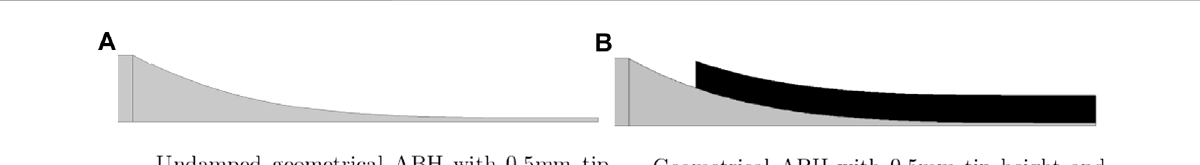
FIGURE 2 Diagrams showing the two ABH con fi gurations. (A) Geometric ABH with 0.5 mm tip height and no damping layer. (B) Geometric ABH with 0.5 mm tip height and additional damping